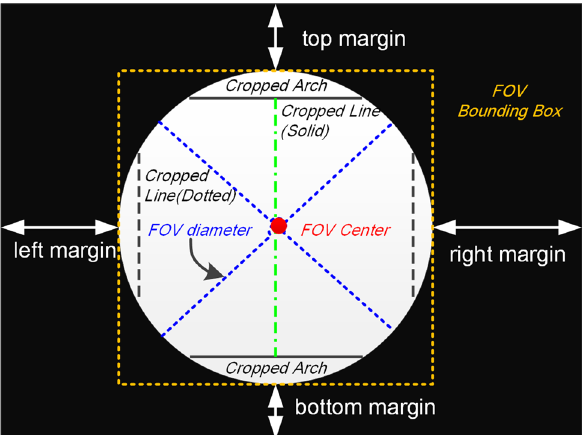
Figure 7. Typical structural composition of a fundus image. FOV is a circle shaped region highlighted by a yellow bounding box. The length of FOV bounding box equals to FOV diameter. The colorized FOV region is surrounded by black pixels. Ideally, there is no circular segment cropped from the FOV. The FOV center is the image center. The left and right margins have the same length. So are the top and and bottom margins.